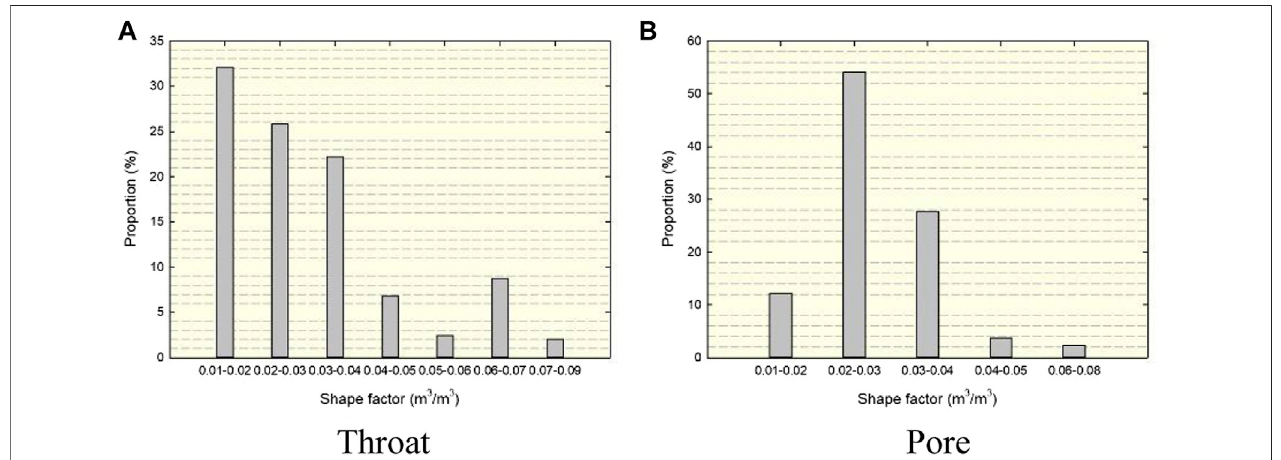
FIGURE 3 | Statistical graph of real core shape factors. (A) Throat (B) and pore.